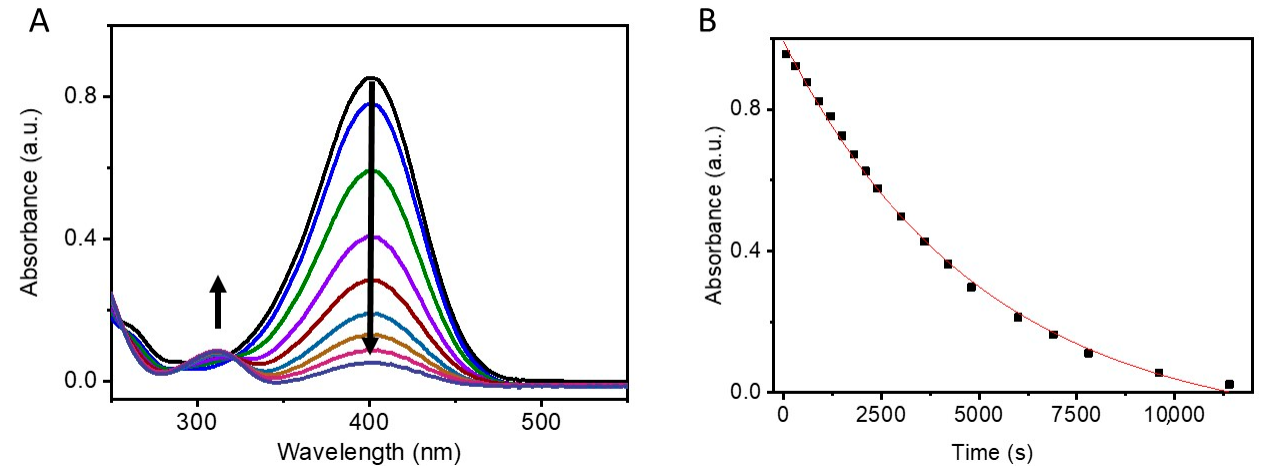
Figure 2. ( A ) Spectral evolution of a mixture of p-NP and borohydride upon addition of one PDMS sponge doped with Au nanoparticles. [p-NP] = 5 × 10 − 5 M, [NaBH 4 ] = 0.1 M at pH = 13. ( B ) Kinetic trace of the absorbance at 400 nm during the reduction of p-NP corresponding to ( A ). The solid line shows the best fit of Equation (1) to experimental data, k app = 1.9 × 10 − 4 s − 1 .